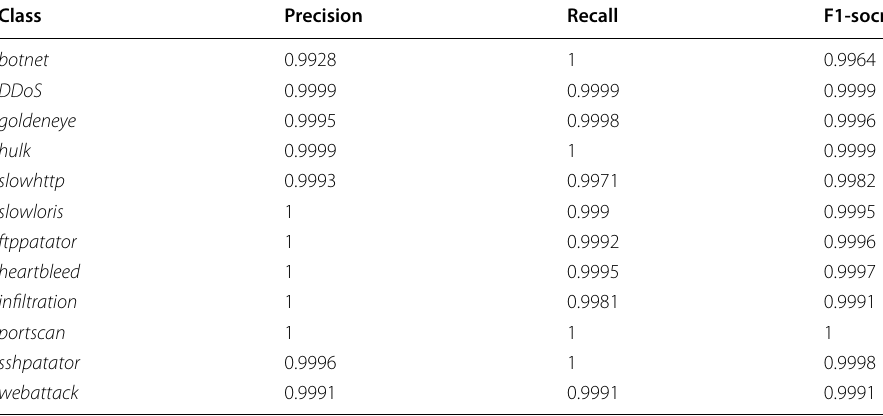
Table 5 Performance of MFVT(CPR) in the IDS 2017 dataset Class Precision